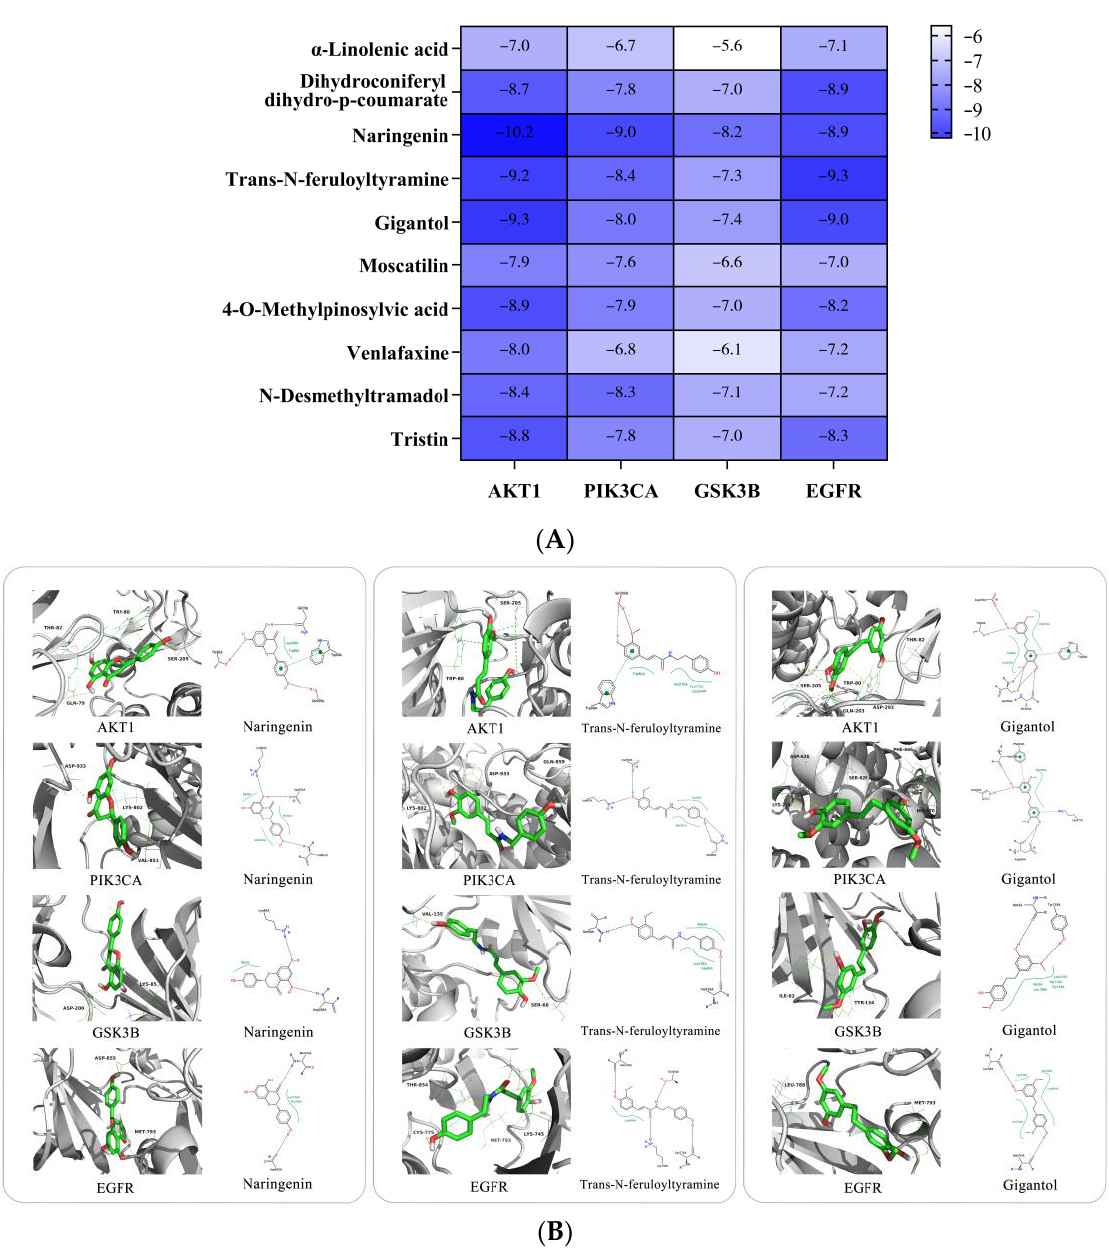
Figure 17. Molecular docking binding energy between key active compounds of D. nobile and core targets ( A ), and molecular docking model of naringenin, trans -N-feruloyltyramine, gigantol with AKT1, PIK3CA, GSK3B and EGFR ( B ).